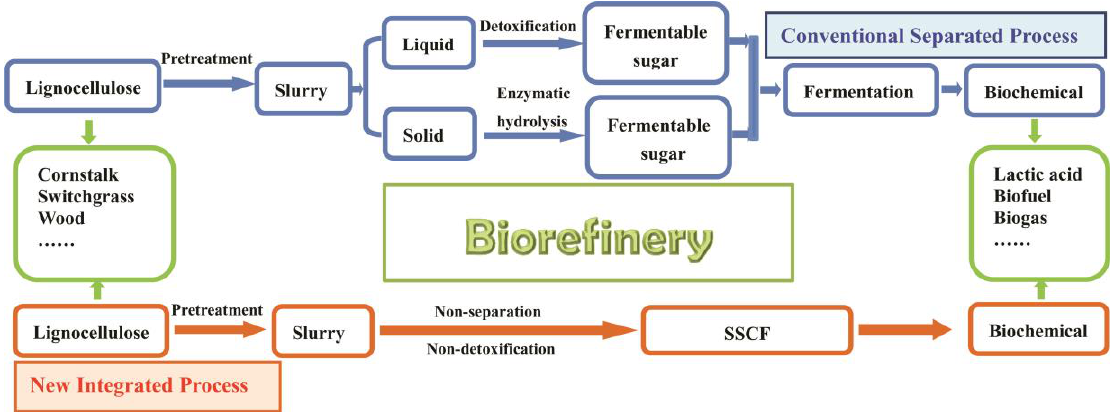
Figure 1. A schematic diagram of the separated process and the integrated process.